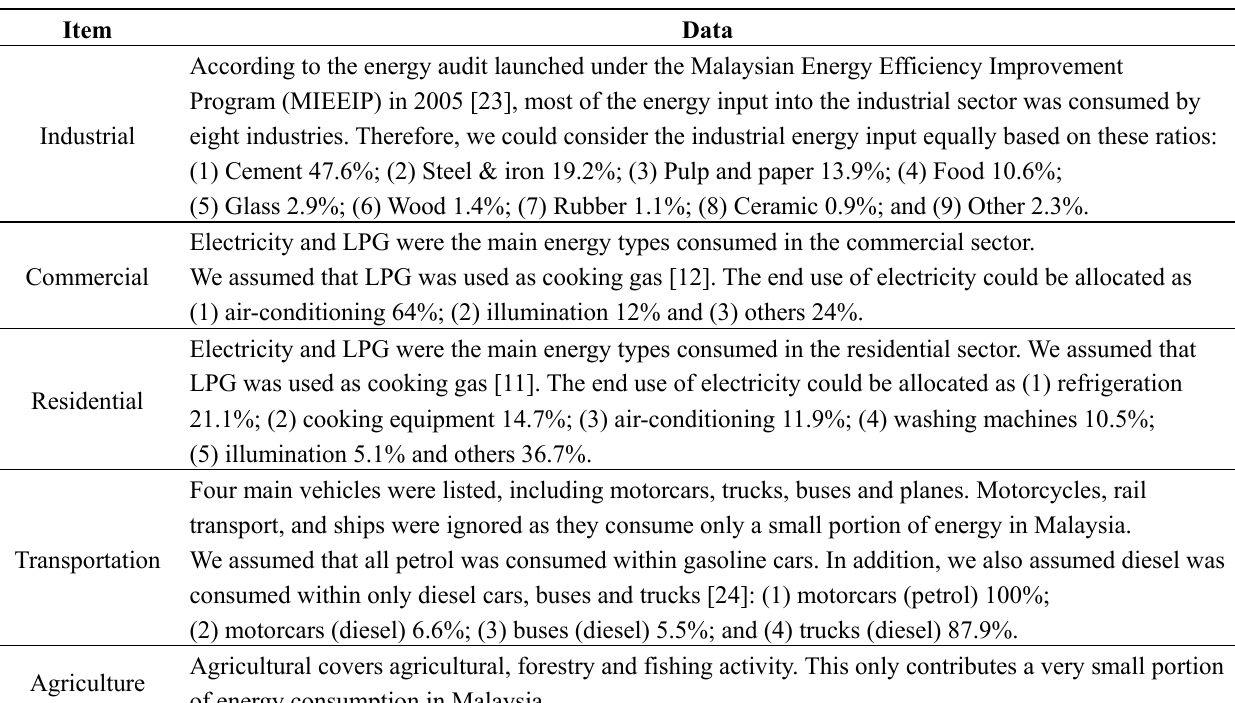
Table 6. Other data required for the